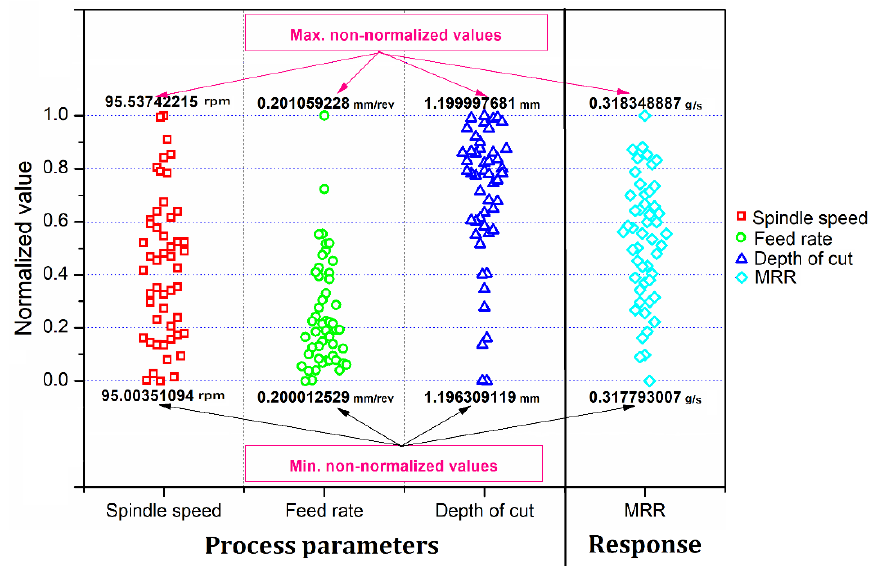
Figure 9. Optimized inputs and output values for 50 independent trials.